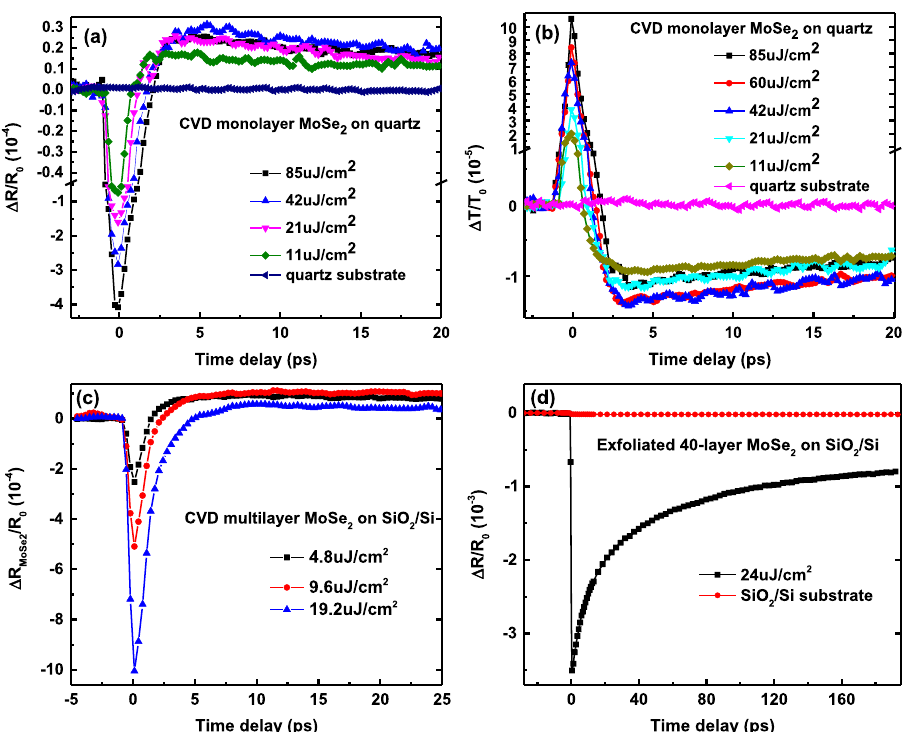
Fig. 5 a and b Differential re fl ection and transmission signals of a CVD grown monolayer MoSe 2 on quartz substrate. c Differential re fl ection signals of a CVD grown 10-layer MoSe 2 on SiO 2 /Si substrate. d Differential re fl ection signal of an exfoliated 40-layer MoSe 2 on SiO 2 /Si